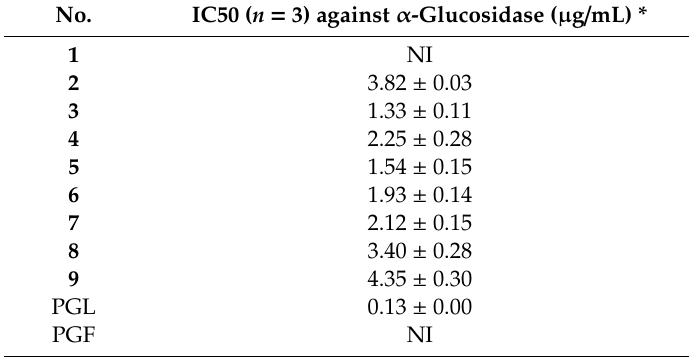
Table 6. IC50 of nine triterpenoids and the methanol extracts of the leaves and fruits of P. guajava against α